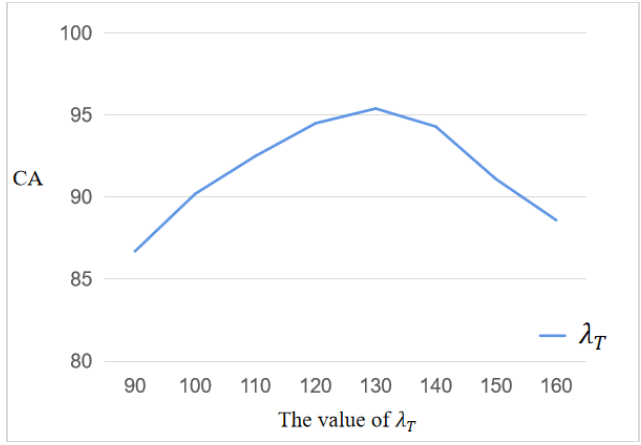
Figure 6. Trend diagram of CA with λ T .